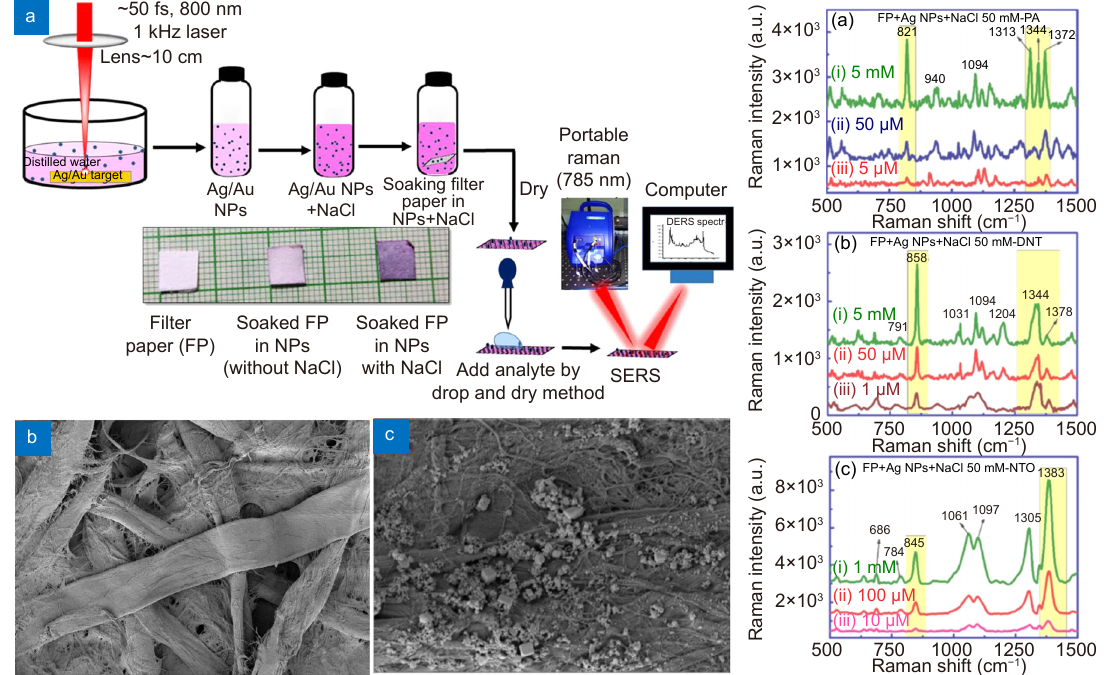
Fig. 6 | Filter paper based SERS substrate by aggregated Ag/Au NPs for explosive molecule detection (Left side) ( a ) schematic of substrate pre- paration ( b ) and ( c ) FESEM images of bare filter and aggregated Ag NPs (Right side) SERS spectra of (a) PA (b) DNT (c) NTO using FP with op- timized aggregated Ag NPs. Figure reproduced with permission from ref. 94 , American Chemical